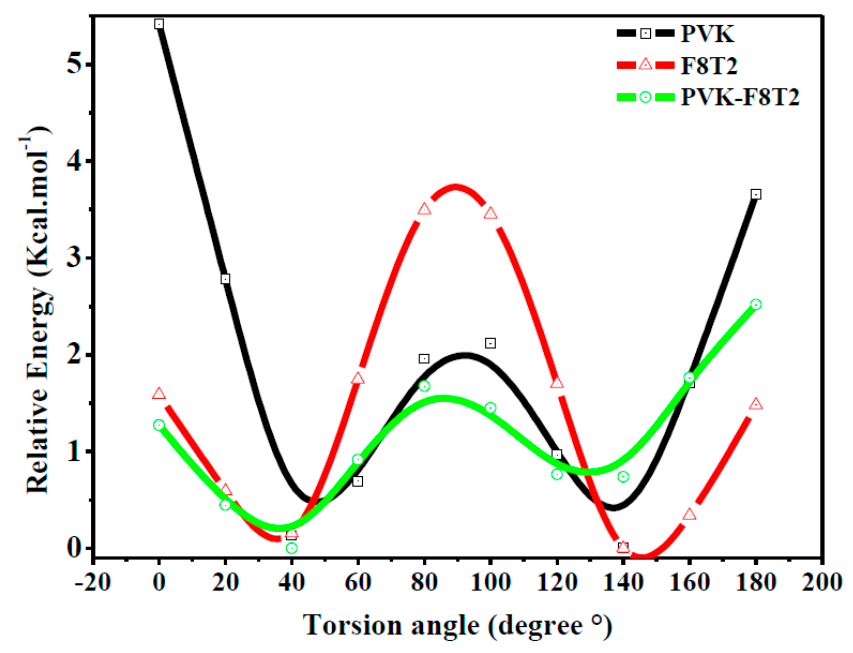
Figure 1. Energy curve of PVK, F8T2 and PVK-F8T2.